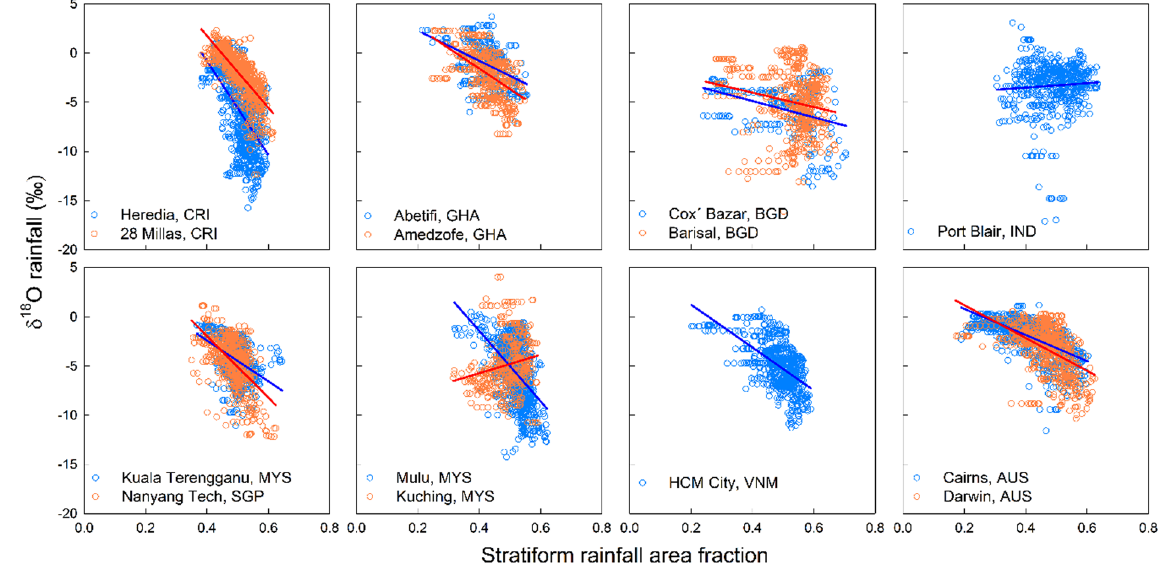
Figure 3. Relationship between10-day moving average of rainfall δ 18 O values and stratiform rainfall area fractions (5° × 5° box centered on each station) at 14 tropical stations. Refer to Table 1 for sampling period for each station and Table 3 for linear coefficients and correlation coefficient (R 2 ).